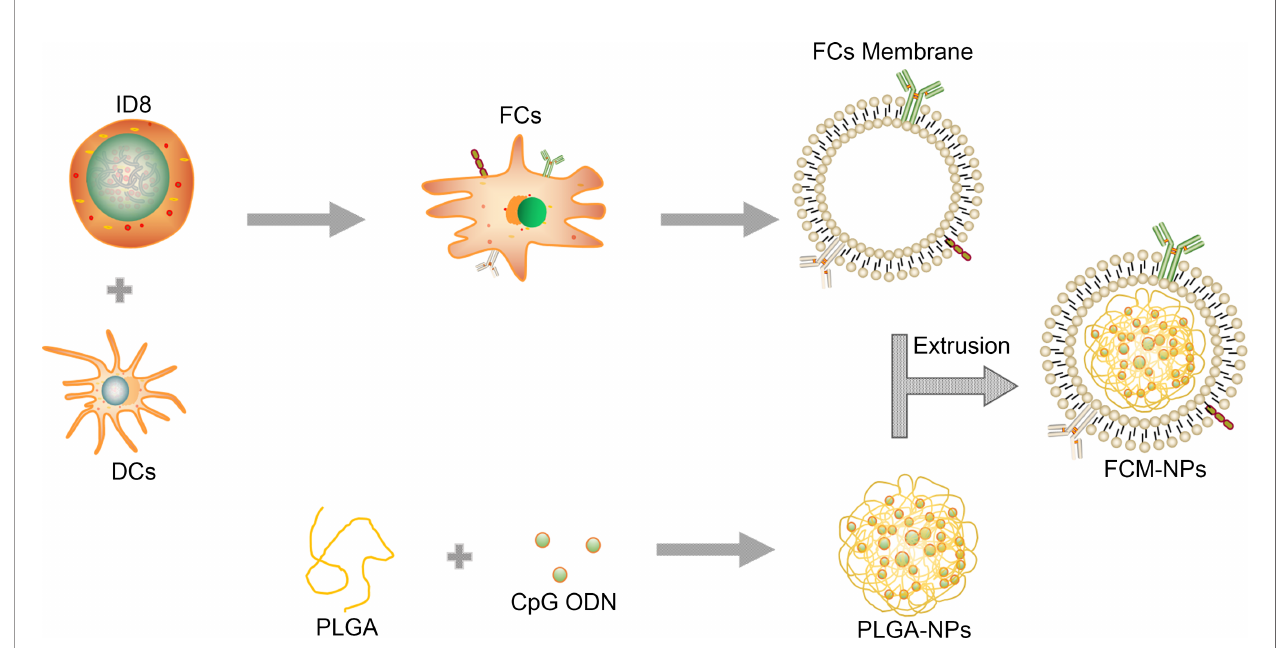
FIGURE 1 | Schematic illustration for the preparation of FCM-NPs. Fusion cells were fi rst prepared from ovarian cancer (OC) cells and mouse dendritic cells (DCs) by PEG method. FCs membrane was then extracted and mixed with CpG ODN-loaded PLGA-NPs, and the FCM-NPs was prepared by extrusion